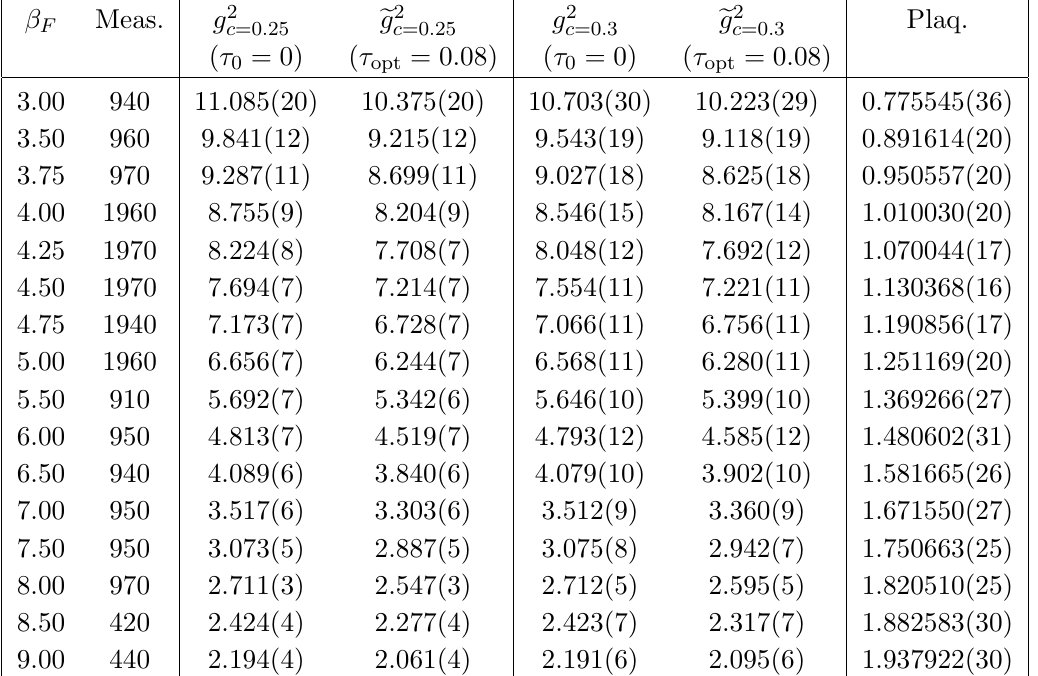
Table 5 . 18 4 lattice ensembles used in this work, with columns as in table 3.